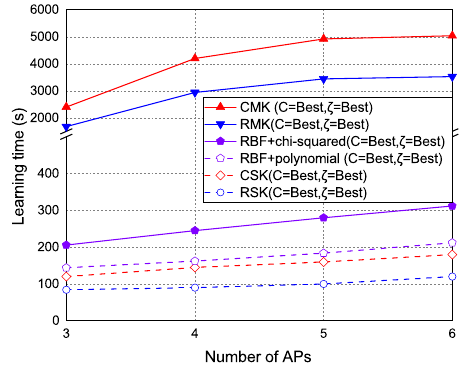
Figure 13. Time cost vs. number of selected